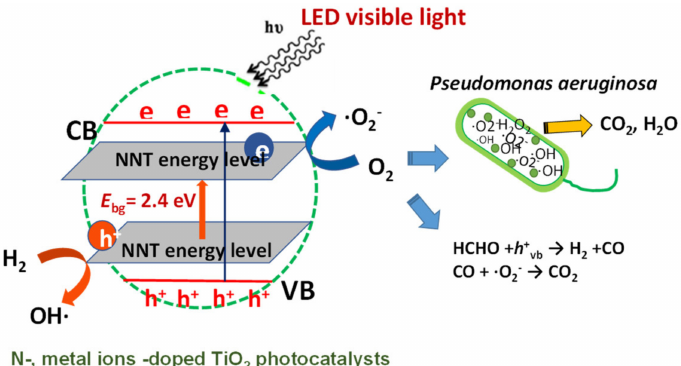
Figure 9. The bandgap change of the TiO 2 photocatalyst doped with metal ions and nitrogen and the reaction mechanism for organic matter and pathogenic